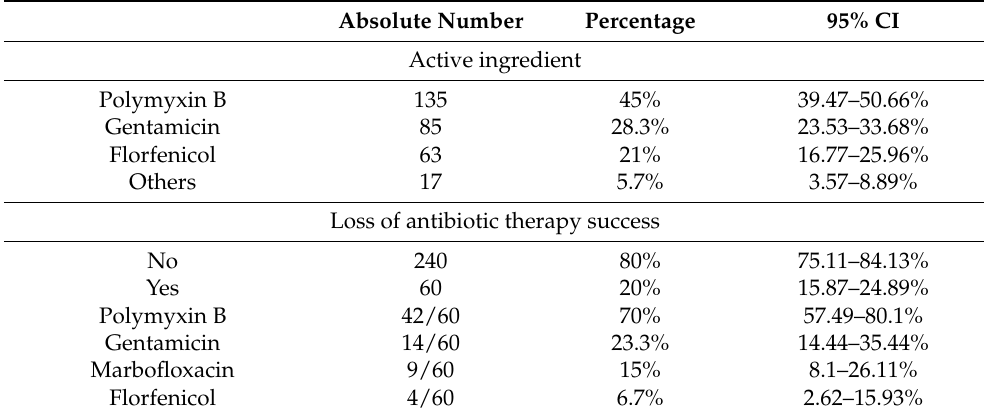
Table 4. Otitis externa. Number, percentages, and 95% CI of responses regarding the disease of otitis externa according to the frequency of the used active ingredients and the antibiotic groups for which a loss of therapeutic success was observed. A total of 300 questionnaires from a survey among German veterinarians were analyzed for this